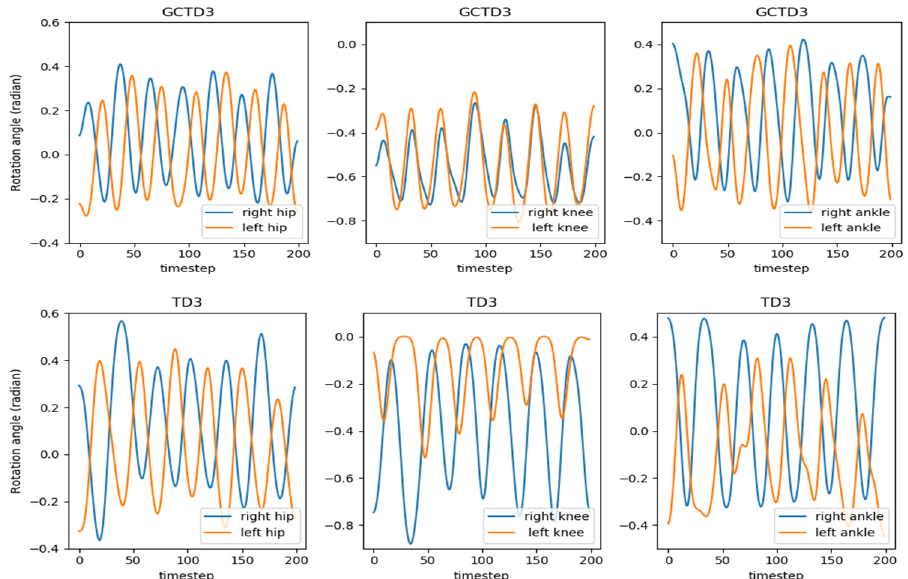
Figure 9. Graph of rotation angle values of hip, knee and ankle joints (from left to right) of GCTD3 and TD3 algorithms (from top to bottom). The blue and orange lines represent the rotation of the joints of the right and left legs over timestep, respectively.